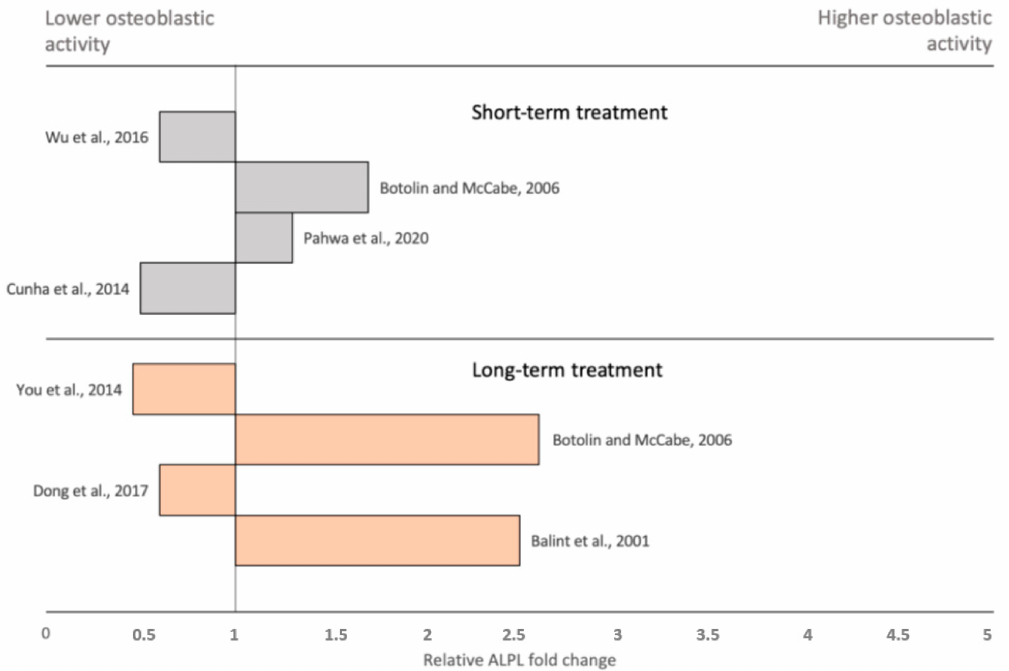
Figure 3. Bar graph displaying relative ALPL fold changes in MC3T3-E1 osteoblastic cells when incubated under hyper- glycemic conditions (>15 mM Glucose) compared to normoglycemia ( ˆ = 5.5 mM Glucose). Gray bars display the results of short-term (1–4 days) incubation; orange bars display the results of long-term (2–4 weeks) incubation. ALPL fold changes show, in summary, no significant differences, even though a tendency towards higher osteoblastic activity in chronic hyperglycemia can be observed in